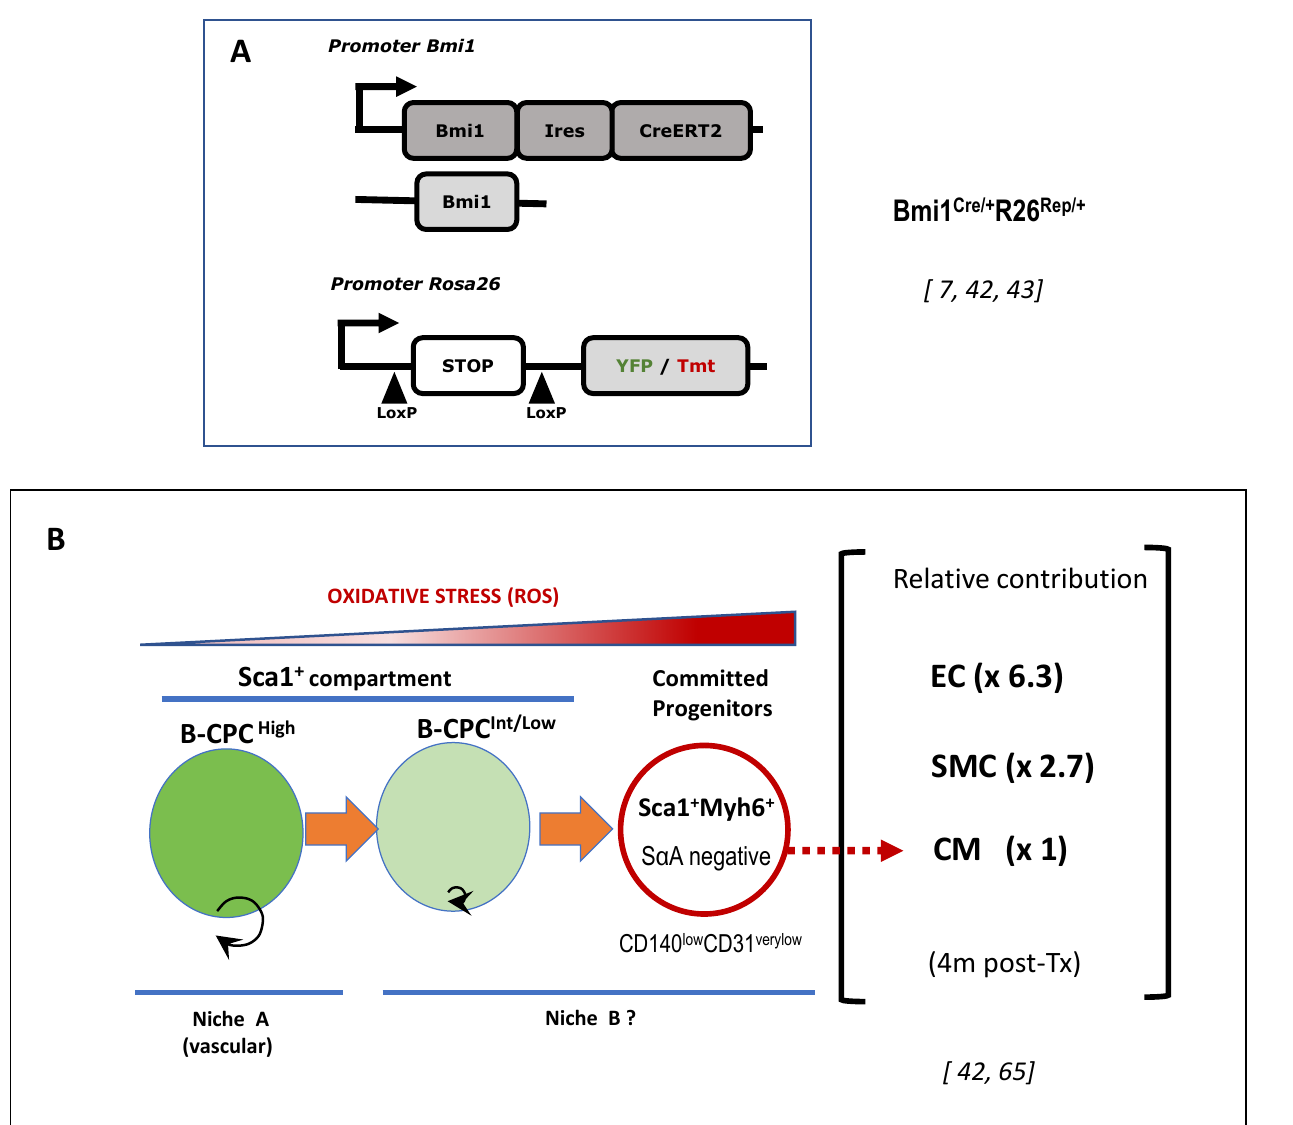
Figure 3. Working model for the differentiation of B-CPC driven by ROS levels. ( A ) Genetic scheme of the mouse strain Bmi1Cre/+R26Rep/+ used for the characterization of B-CPC regu- lation/differentiation. Rep, indicates the use of YFP or Tmt as reporter; LoxP, specific LoxP sites for the Cre recombinase. ( B ) The B-CPC compartment is not in equilibrium with exogenous or endogenous precursors. B-CPC is a heterogeneous Sca1+ population with respect to Bmi1 expression levels. B-CPChigh correspond to the more immature and quiescent progenitors and most probably associate with a dedicated vascular niche (Niche A). It is proposed that later, ontogenically speaking, subpopulations B-CPCint/low and Sca1+Myh6+ cardiomyocyte (CM) committed progenitors could be associated with other pro-differentiation-biased niches (Niche B). In fact, it has been demonstrated that proliferative activated B-CPC are located more distantly with respect to the cardiac vessels. Progeny of B-CPC, 4-months after labeling is composed (relative to CM) by a 2.7 fold increase for smooth muscle cells (SMC) and 6.3-fold for endothelial cells